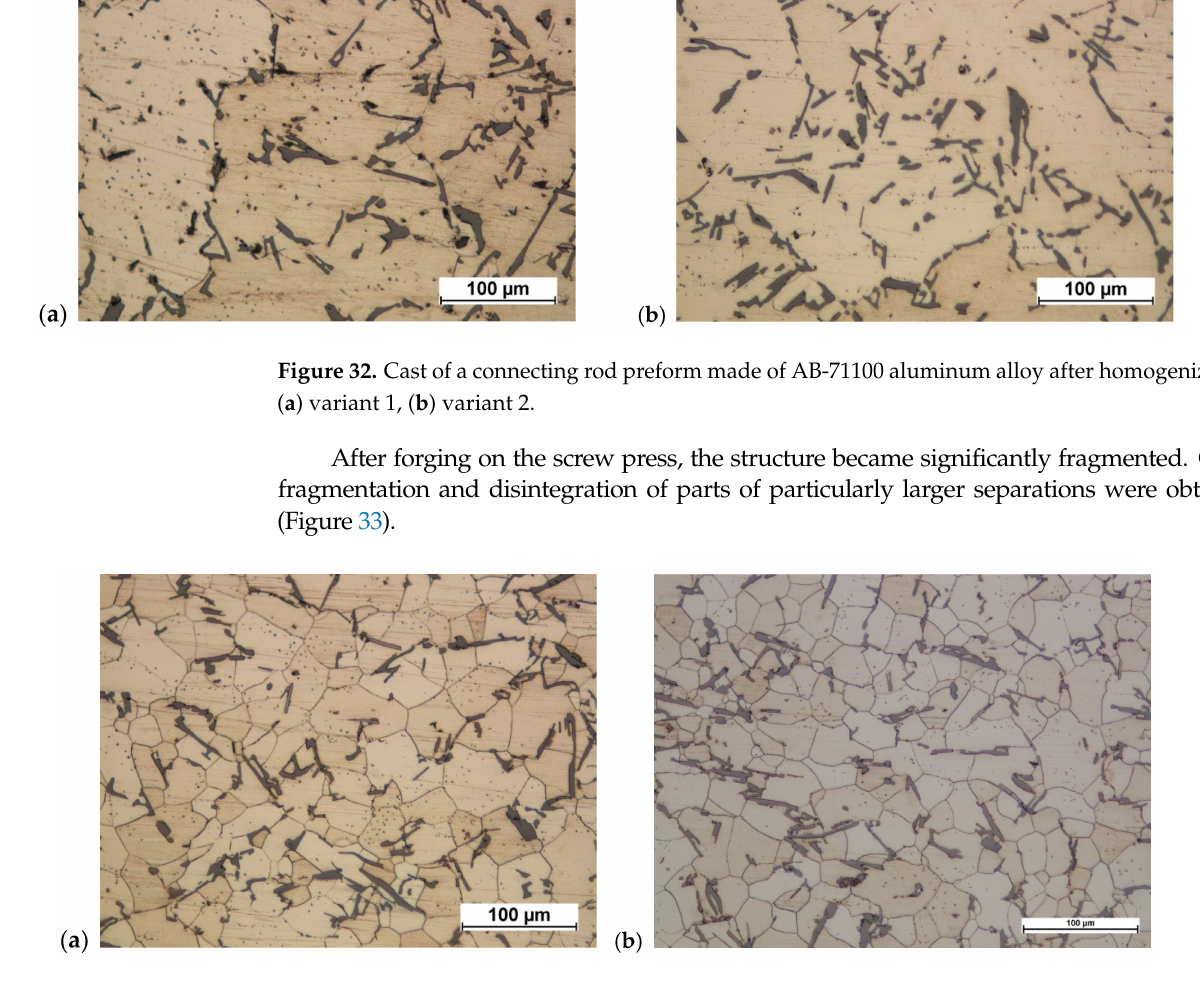
Figure 33. Connecting rod forging forged from a preform in accordance with variant 2: ( a ) on a screw press; ( b ) on a screw press and after heat